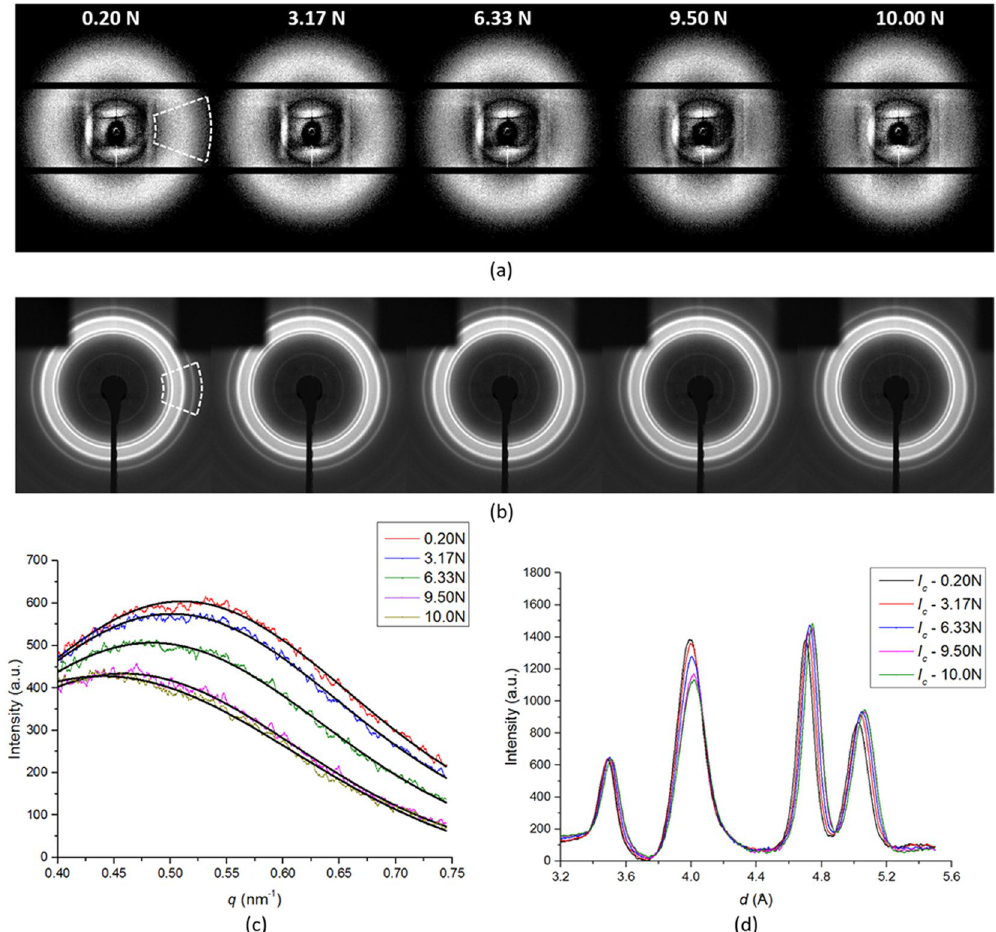
Figure 1. Structural evolution of 2D scattering patterns and 1-D profiles. Selected (a) SAXS patterns and (b) WAXS patterns for final loading stage (0.2–10 N); the family of equivalent 1D profiles of scattered (c) SAXS intensity with Gaussian curve fitting and (d) WAXS intensity with Gaussian curve